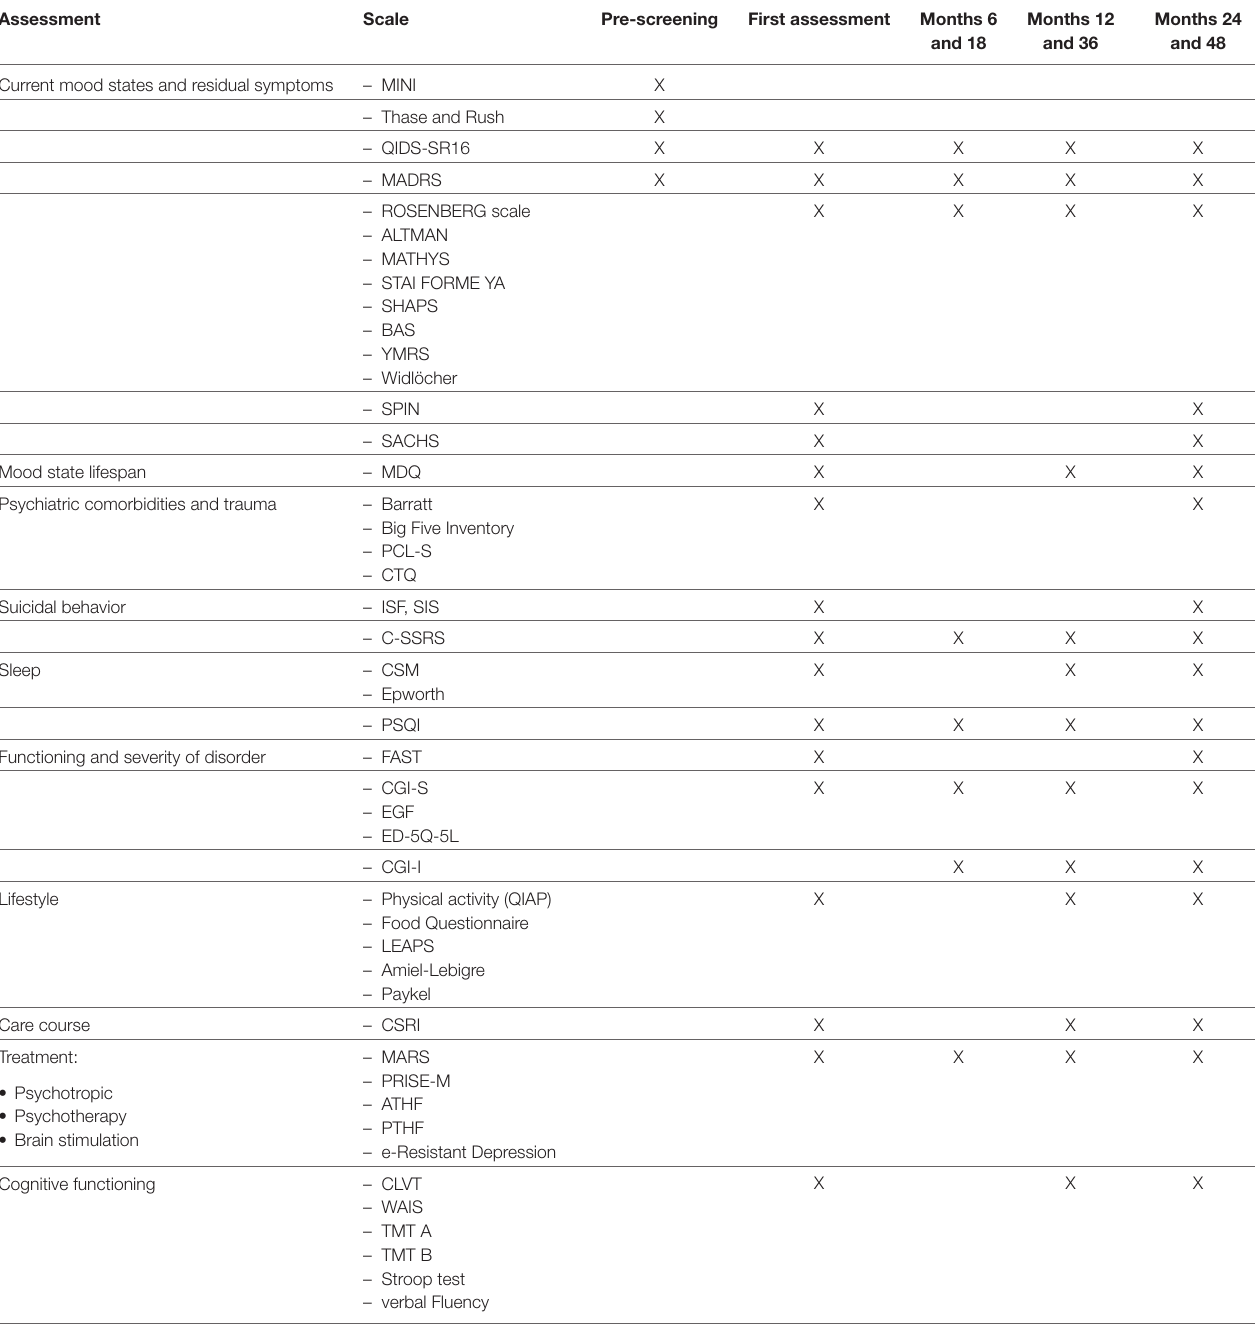
taBlE 2 | Standardized scales of